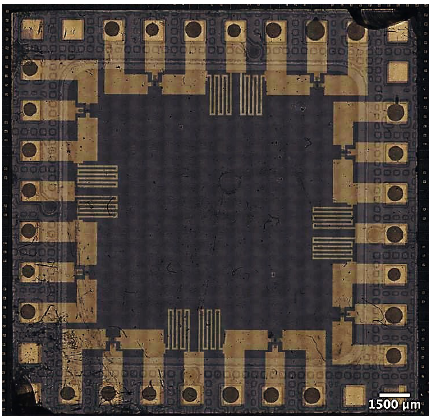
Figure 17. Mounted ITO-coated glass with printed